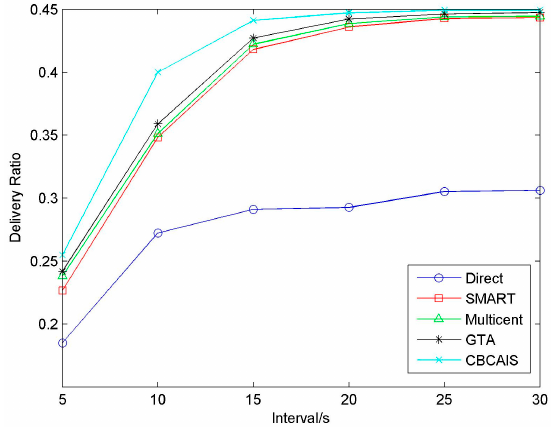
Figure 17. Delivery ratio for varying message generation interval.